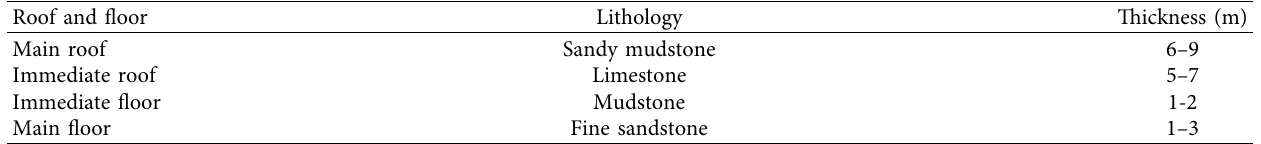
Figure 1: 9-301 working face layout. Table 1: Roof and floor of the working face.